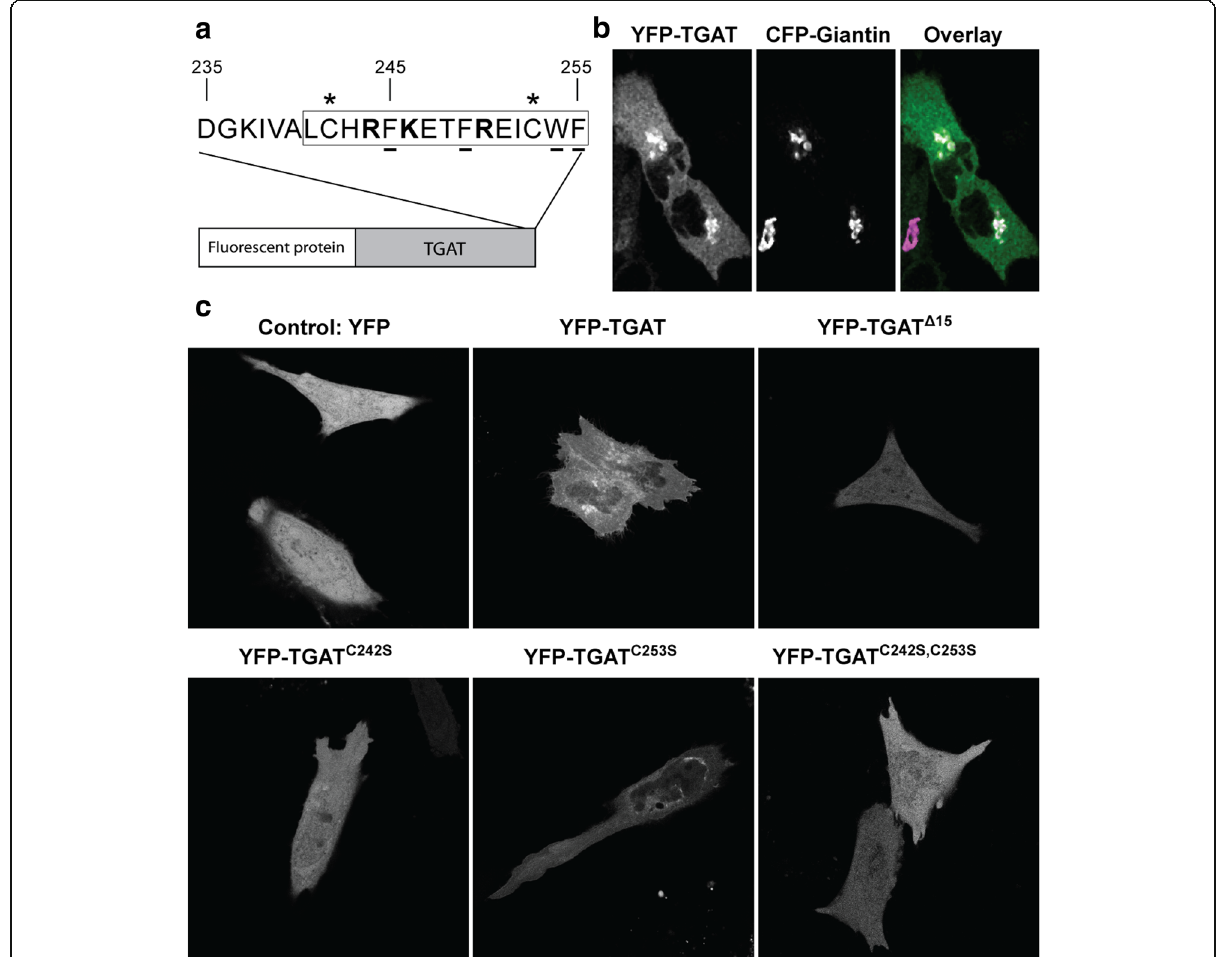
Fig. 1 Subcellular localization of TGAT variants and quantification of their plasma membrane localization. a Schematic overview of TGAT fused to a fluorescent protein at its N-terminus. The blowout shows the last 20 amino acids of the C-tail of TGAT, with the last 15 amino acids indicated by the rectangle. Positively charged amino acids are shown in bold, amino acids with hydrophobic side-chains are underlined and the two cyste- ines at position 242 and 253 marked with an asterisk. b Confocal microscopy images of HeLa cells co-transfected with YFP-TGAT and the Golgi marker CFP-Giantin. The color overlay was generated by using the TGAT image for the green channel and the Golgi image for the blue and red channel (=magenta). Consequently, colocalized objects appear as white ( right ). c Confocal microscopy images of HeLa cells transfected with YFP, YFP-TGAT, YFP-TGAT Δ 15 , YFP-TGAT C242S , YFP-TGAT C253S , YFP-TGAT C242S, C253S . Width of the individual images is 60 μ m in ( b ) and 110 μ m in ( c